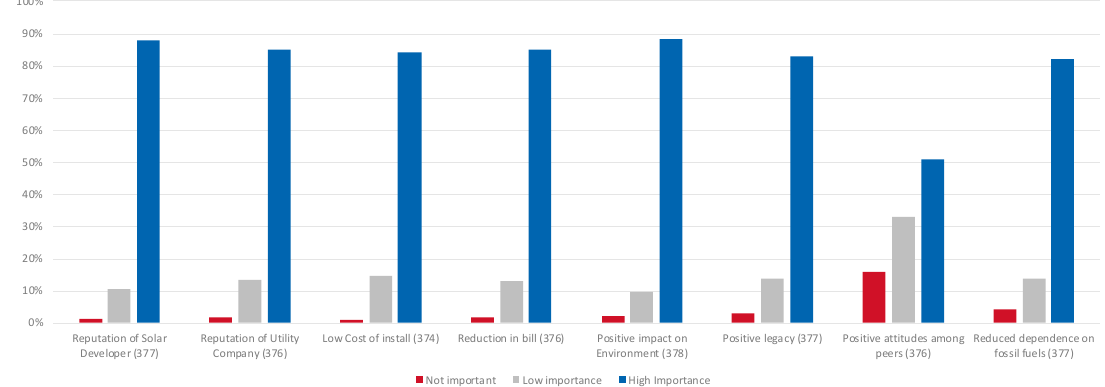
Figure 10. Factors Motivating Support for Solar.